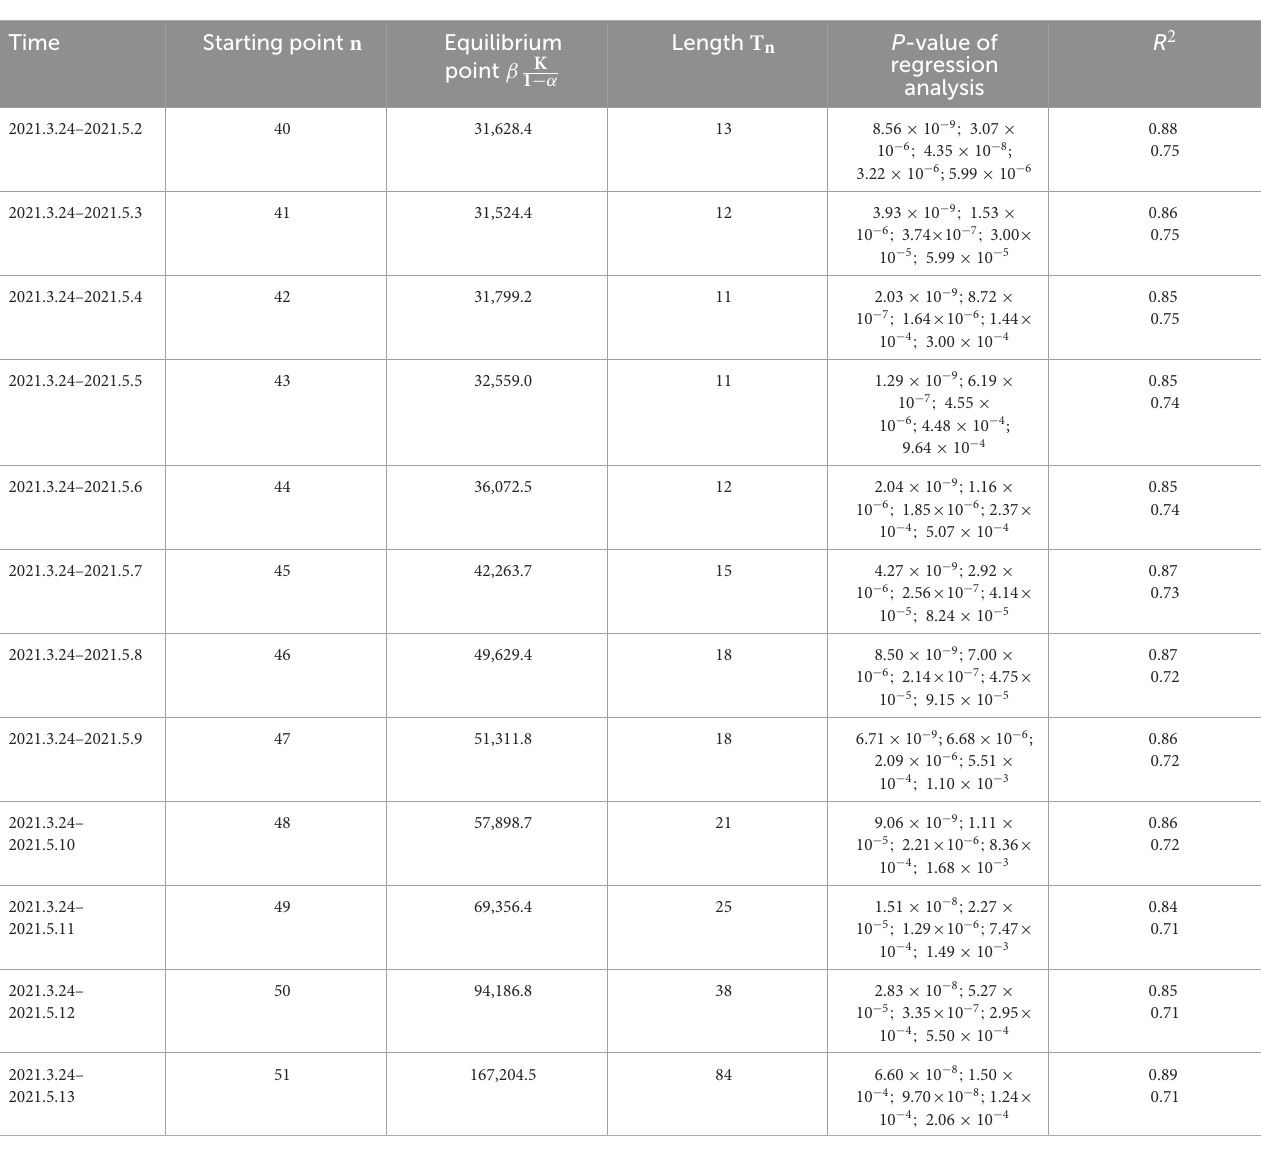
TABLE 3 Prediction data of the first stage.